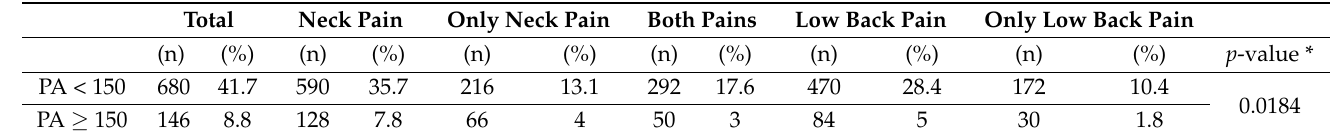
Table 3. Students with musculoskeletal pai divided by physical activity